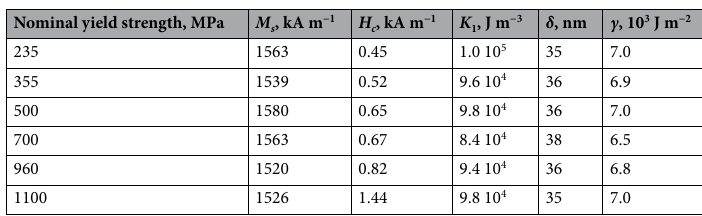
Table 3. Magnetic parameters obtained from the VSM measurements.